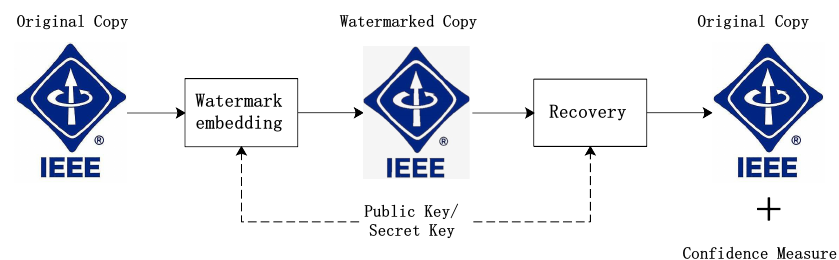
Figure 2. The workflow of digital